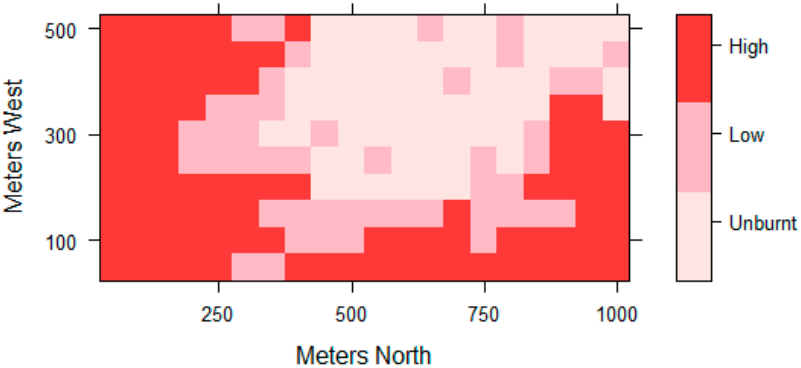
Figure 4. Map represents quadrat classifications according to fire intensity in Huai Kha Khaeng Forest Dynamics Plot, Thailand. Red coloring intensity refers to the increasing of fire intensity.